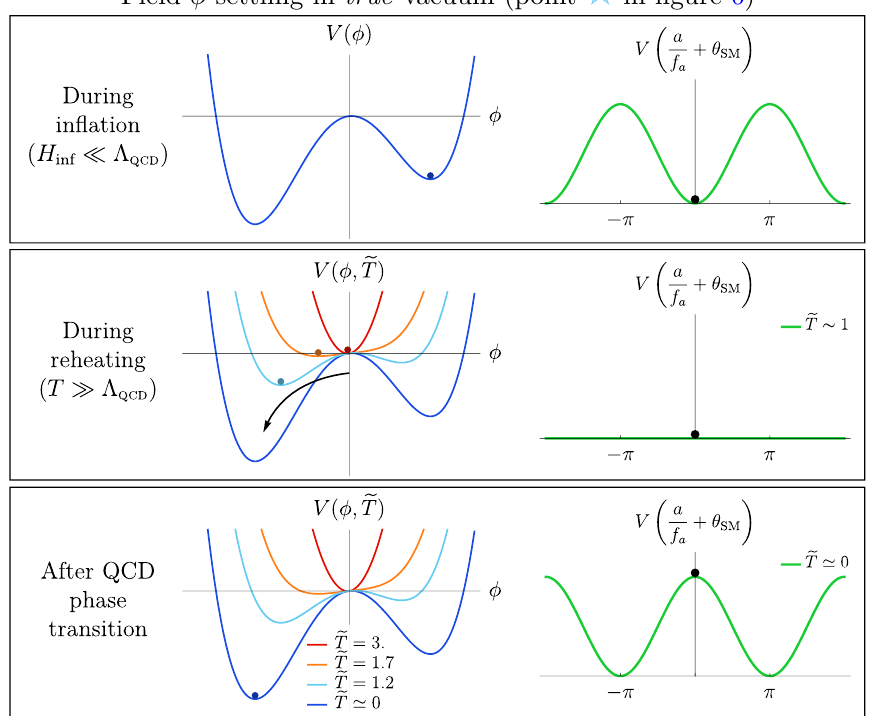
Figure 1 . Dynamics for the real scalar (cid:12)eld (cid:30) and the axion (cid:12)eld a in the early Universe. Coloured lines show their potentials at speci(cid:12)c temperatures, and the corresponding dots represent the (cid:12)eld values at those times. We show here the case in which the (cid:12)eld (cid:30) lies in its false vacuum during in(cid:13)ation and ends up in its true vacuum today. For visualisation purposes, the Yukawa coupling y is taken to be positive in these (cid:12)gures. Top panel: we assume that the Hubble rate during in(cid:13)ation is below the QCD scale, so that the QCD potential for the axion is turned on and a lies in the minimum where the x -axis coordinate of the right-hand side plots a=f a + (cid:18) SM = 0 (see eq. (1.8)). Central panel: during the thermal phase, the scalar (cid:30) and a coloured fermion q are produced in the thermal bath and induce corrections to the e(cid:11)ective potential V ( (cid:30) ) that lift the two minima of (cid:30) . As the temperature decreases and thermal corrections diminish, for this choice of parameters of V ( (cid:30) ) (corresponding to the blue star in (cid:12)gure 6) the (cid:12)eld (cid:30) settles in the true vacuum. During this period T (cid:29) (cid:3) QCD and the axion potential is turned o(cid:11). Bottom panel: the (cid:12)eld (cid:30) settles in its true vacuum, which has opposite sign with respect to its VEV during in(cid:13)ation. Accordingly, the mass of q changes sign and this introduces a shift of (cid:25) in the argument of the mass matrix of coloured fermions. Therefore the axion potential shifts by (cid:25) , whereas the initial value of a has not changed since in(cid:13)ation. The initial misalignment of the axion (cid:12)eld is close to maximal. Note that in this panel, the mass of the fermion q is negative, and the overall (cid:18) angle that we measure in EDM experiments, that is, (cid:18) = a=f a + (cid:18) SM + arg [ m q ], has a minimum at (cid:18) = 0.